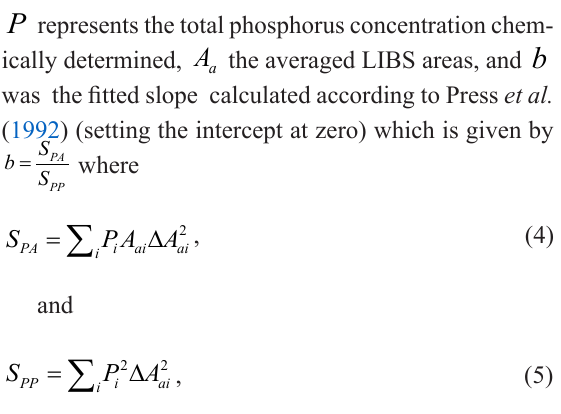
Fig. 3 Example of three spectra ac - quired for a sample with their corre- sponding Lorentz fit